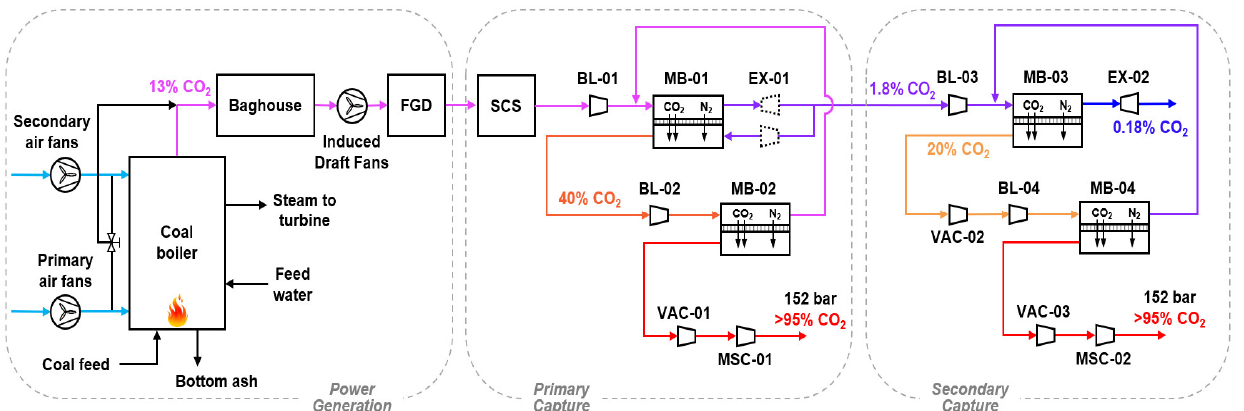
Figure 1. Schematic of the primary and secondary membrane systems for >90% CO 2 capture. Initialisms: flue gas desulfurization (FGD), SO 2 caustic scrubber (SCS), blower (BL), membrane (MB), expander (EX), vacuum pump (VAC), and multistage compressor (MSC).